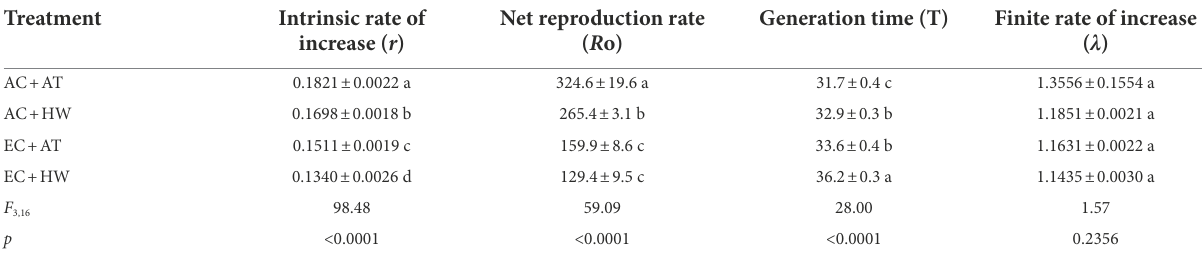
p <0.0001 <0.0001 0.2356 Mean ± SE. Means within the same column followed by different letters are significantly different at p ≤ 0.05, as determined by an ANOVA: LSD test. The lowercase letters after the numbers are used to show the significance of the differences between the